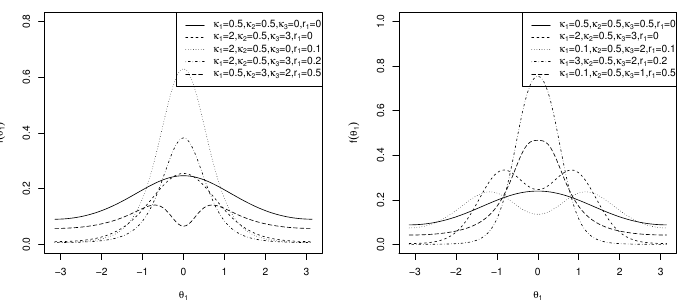
Figure 3. Plots of the marginal pdf of Θ 1 in (12) ( left ) and in (18) ( right ) for µ 1 = 0 and different parameter